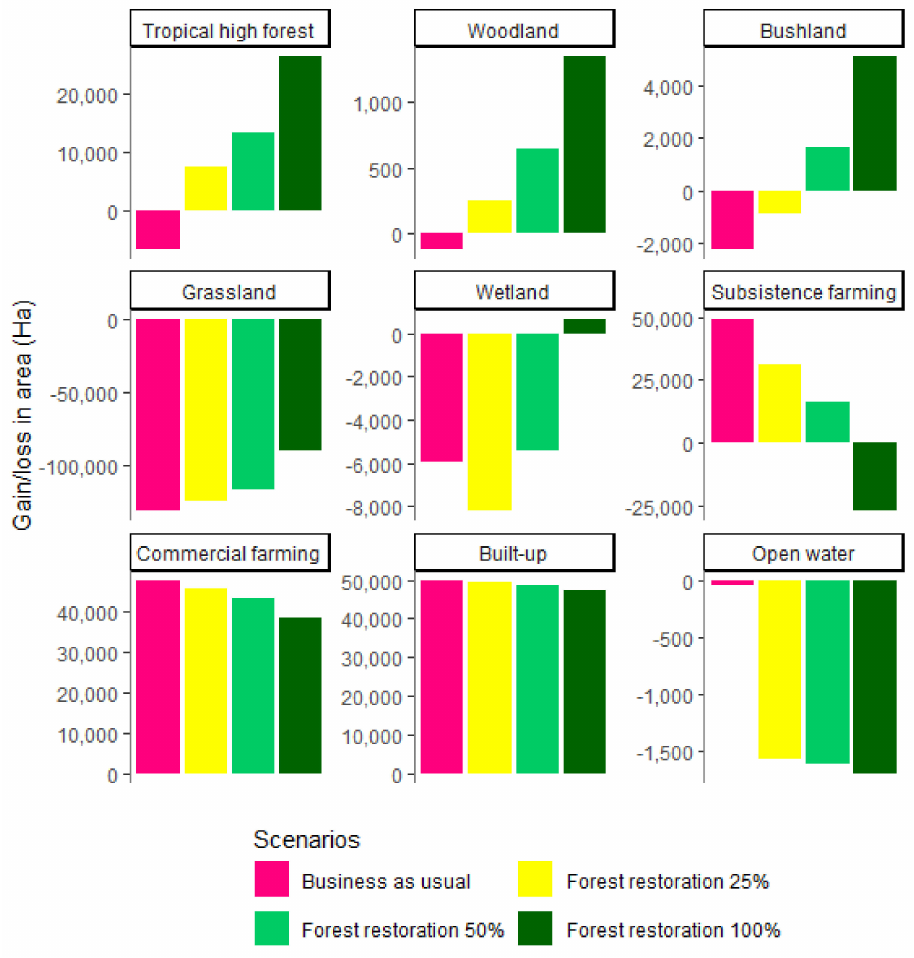
Figure 5. Predicted LULC gain and loss for Budongo–Bugoma landscape under different